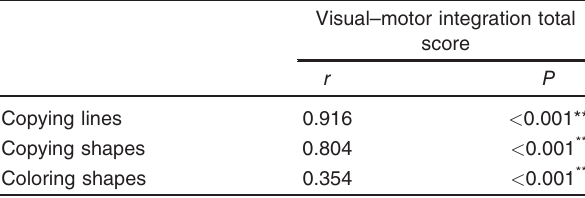
Table 4 Correlation between visual – motor integration total